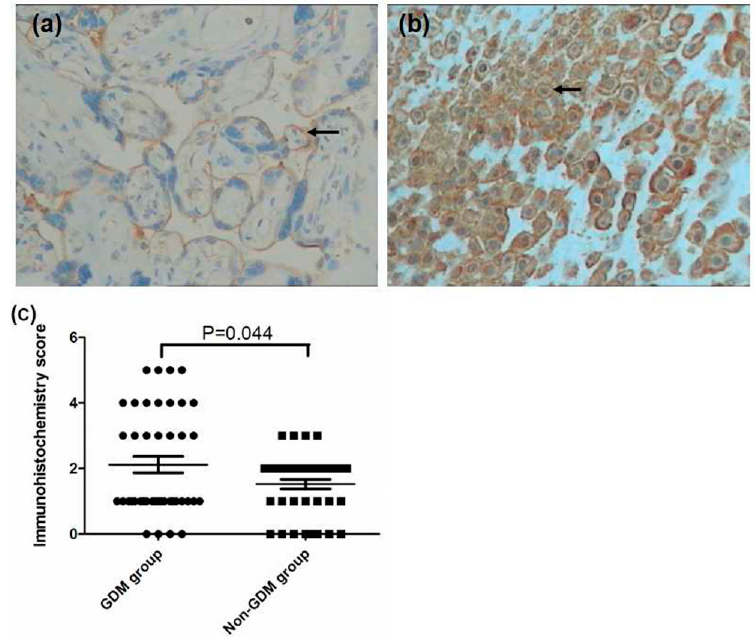
Figure 3. Immunohistochemistry images demonstrated that the lower expression of Hep on membrane of the basal cells (as arrow) from the GDM group ( a ) than that in non-GDM group ( b ) ( × 200 magnification). Lower immunohistochemistry score were found in the GDM group compared with the non-GDM group ( c , p = 0.044).